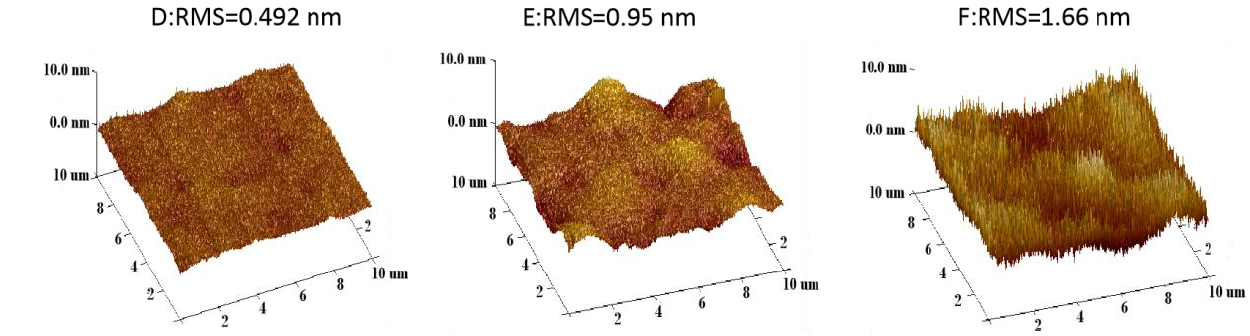
Figure 6. AFM analysis of samples D, E, and F.